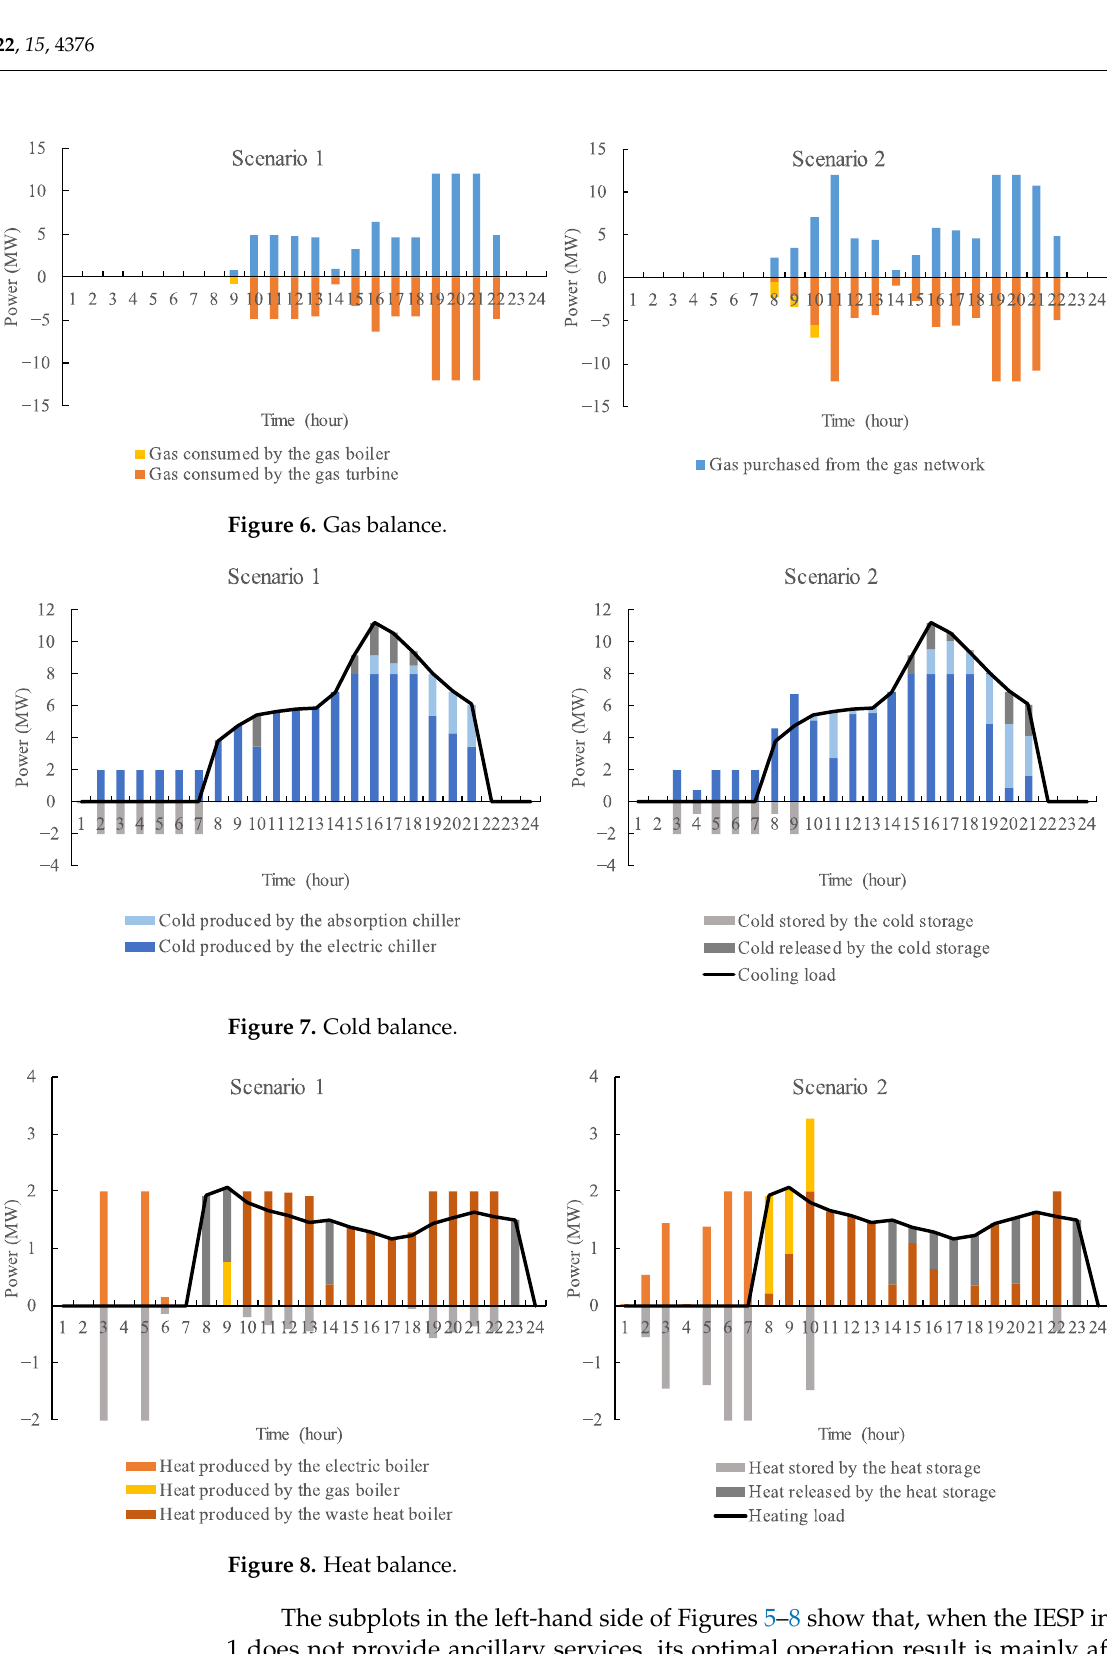
Figure 8. Heat Figure 8. Heat balance. Figure 8. Heat balance.